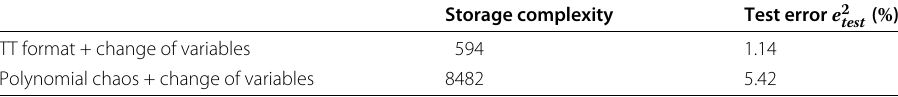
Table 1 Storage complexity and test error of the approximations obtained with the change of variable and with and without using Tensor Train (TT)